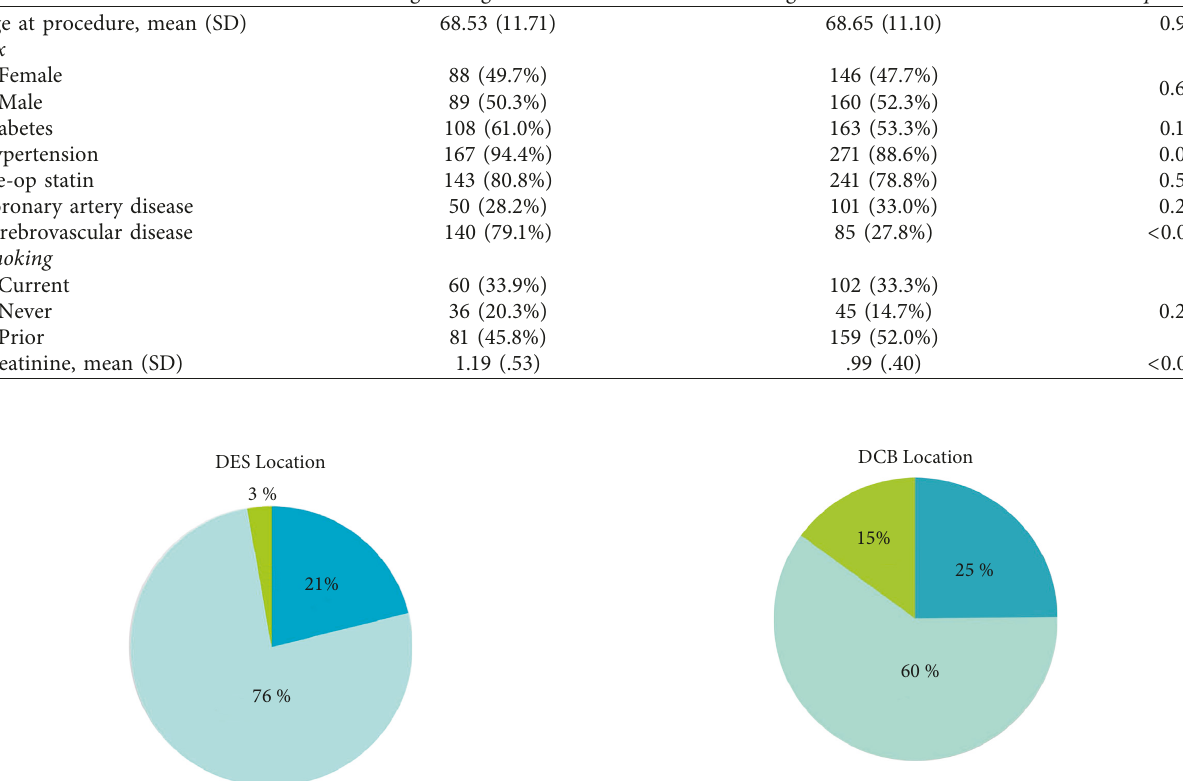
Table 1: Baseline demographics between the drug-eluting stent and drug-coated balloon treatment groups. Factor